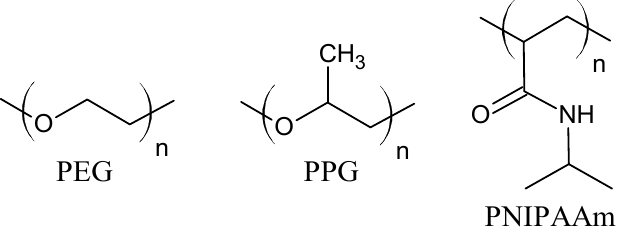
Figure 2. Molecular structure of poly(ethylene glycol) (PEG), poly(propylene glycol) (PPG), and poly( N -isopropylacrylamide) (PNIPAAm).